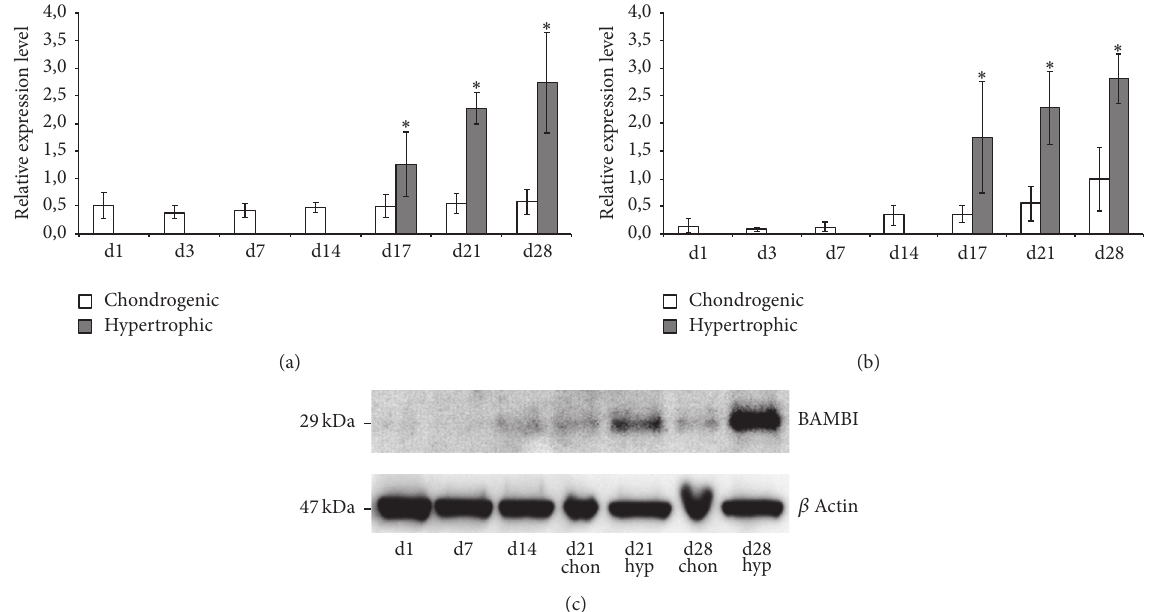
Figure 3: (a) Gene expression analysis of BAMBI and (b) BMP4 normalized to HPRT in MSC pellet cultures under chondrogenic and hypertrophy enhancing conditions analysed by real-time PCR. BAMBI and BMP4 are significantly upregulated under hypertrophic conditions compared to chondrogenic controls on days 17, 21, and 28. 𝑛 = 7 different donors, ∗ 𝑝 < 0.001 . (c) Western blot analysis of BAMBI: increased amount of BAMBI protein can be detected under hypertrophic conditions on days 21 and 28 compared to chondrogenic conditions.